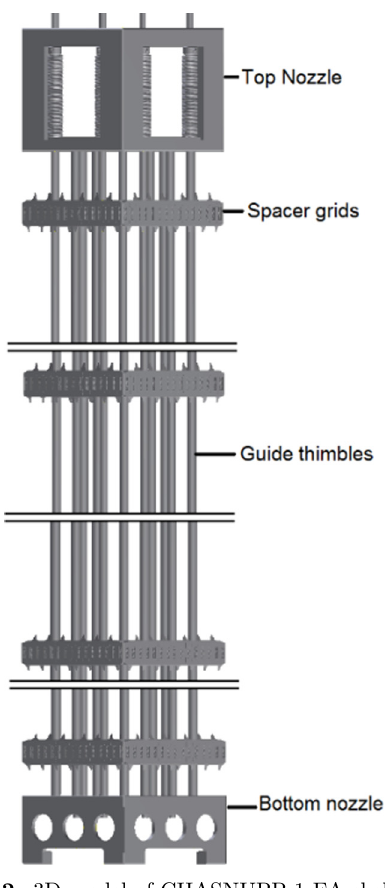
Fig. 2. 3D model of CHASNUPP-1 FA skeleton.